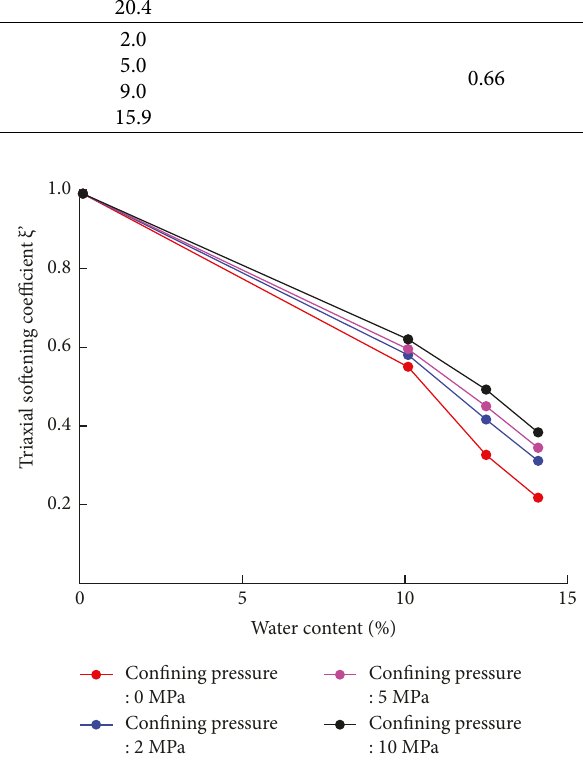
Figure 8: Triaxial softening coefficient curve of